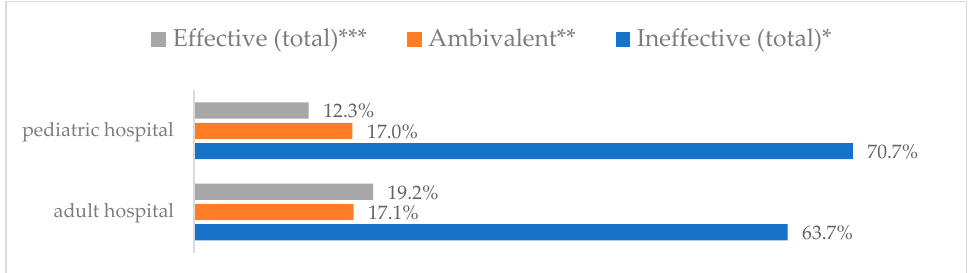
Figure 23. Eating garlic to prevent influenza virus infection by type of hospital ( N = 905). *Sum of responses: completely ineffective, ineffective, rather ineffective; **Response: neither ineffective nor effective; ***Sum of responses: rather effective, effective, completely effective.